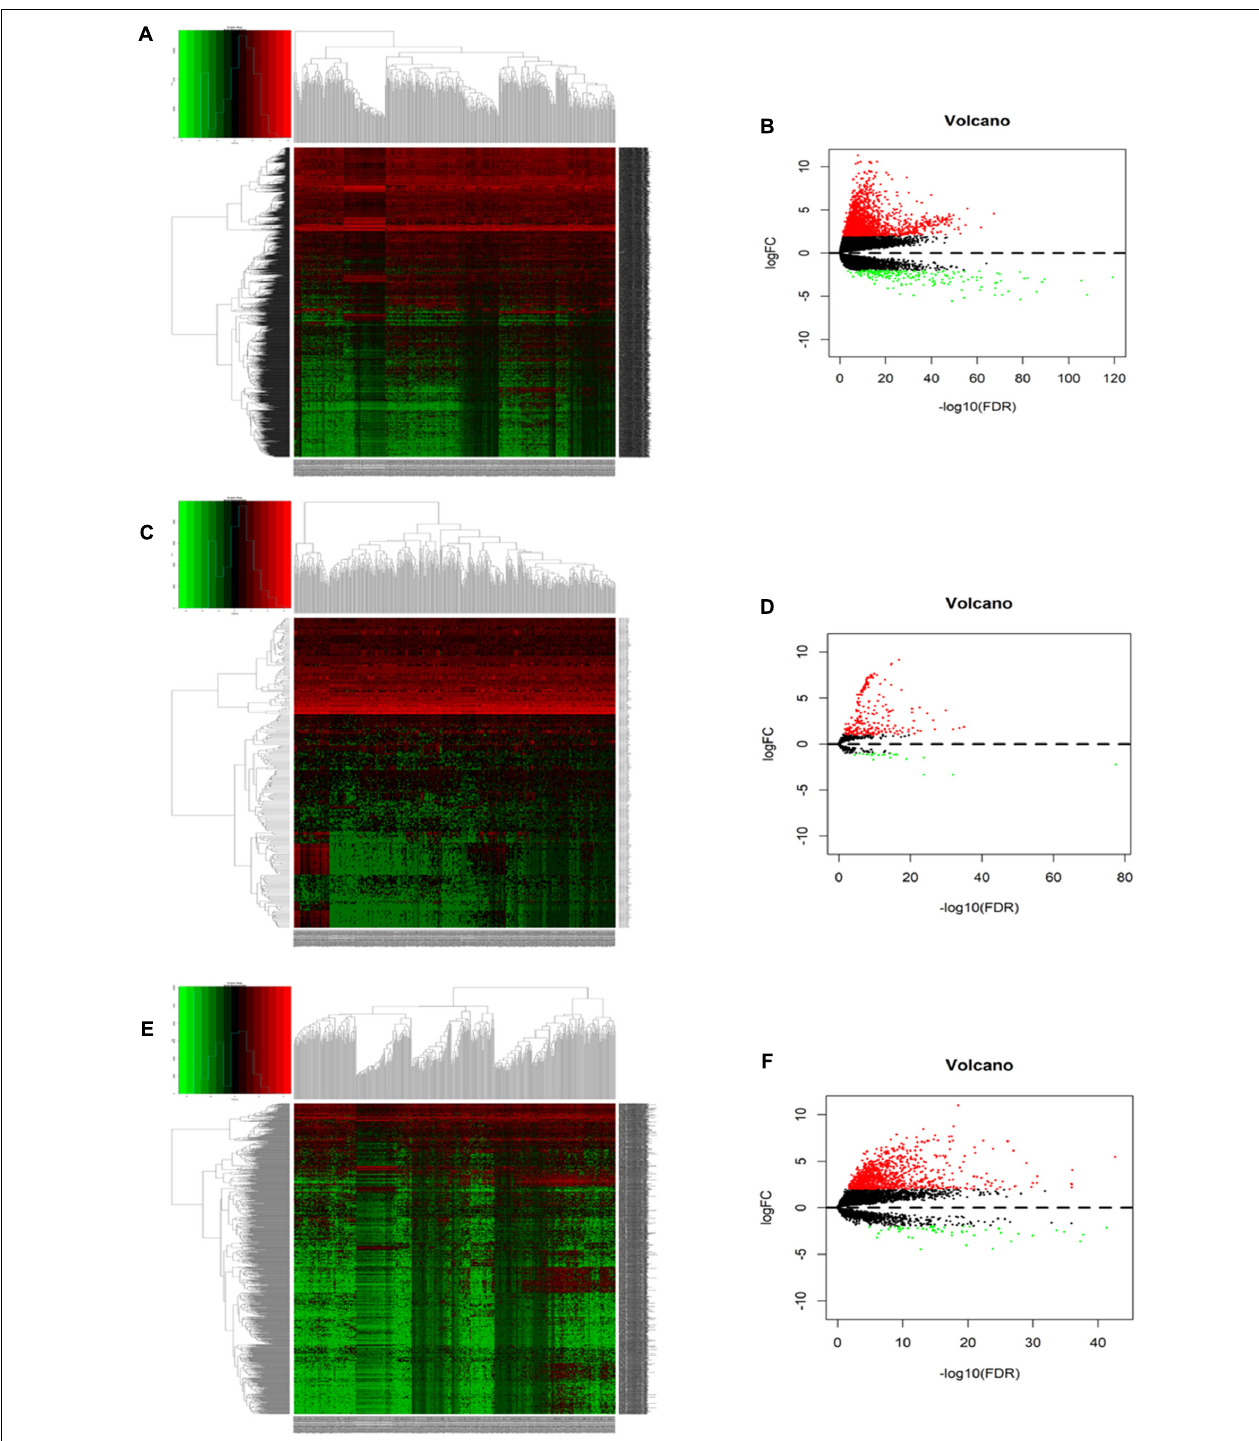
FIGURE 2 | The hierarchical clustering heatmaps and volcano plots for all screened differentially expressed mRNA, miRNA and lncRNA in HCC based on TCGA data. Heatmaps located in the left panels represent differential expressed (DE) mRNAs (A) , miRNAs (C) , and lncRNAs (E) . Volcano plots located in the right panels indicate DEmRNAs (B) , DEmiRNAs (D) , and DElncRNAs (F) with the cutoff criteria of fold change ≥ 2 and P -value < 0.05. Red color: upregulated, green: downregulated, gray: not statistic